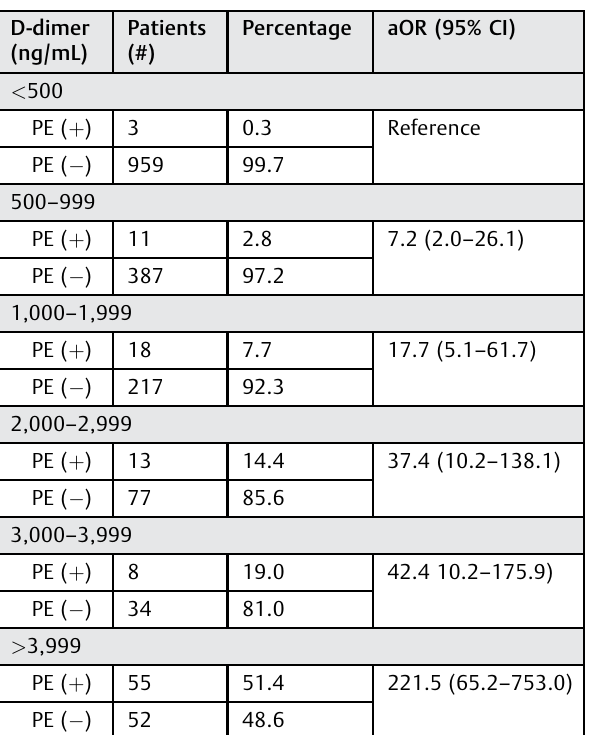
Table 3 Proportion of PE-positive and PE-negative patients by D-dimer result